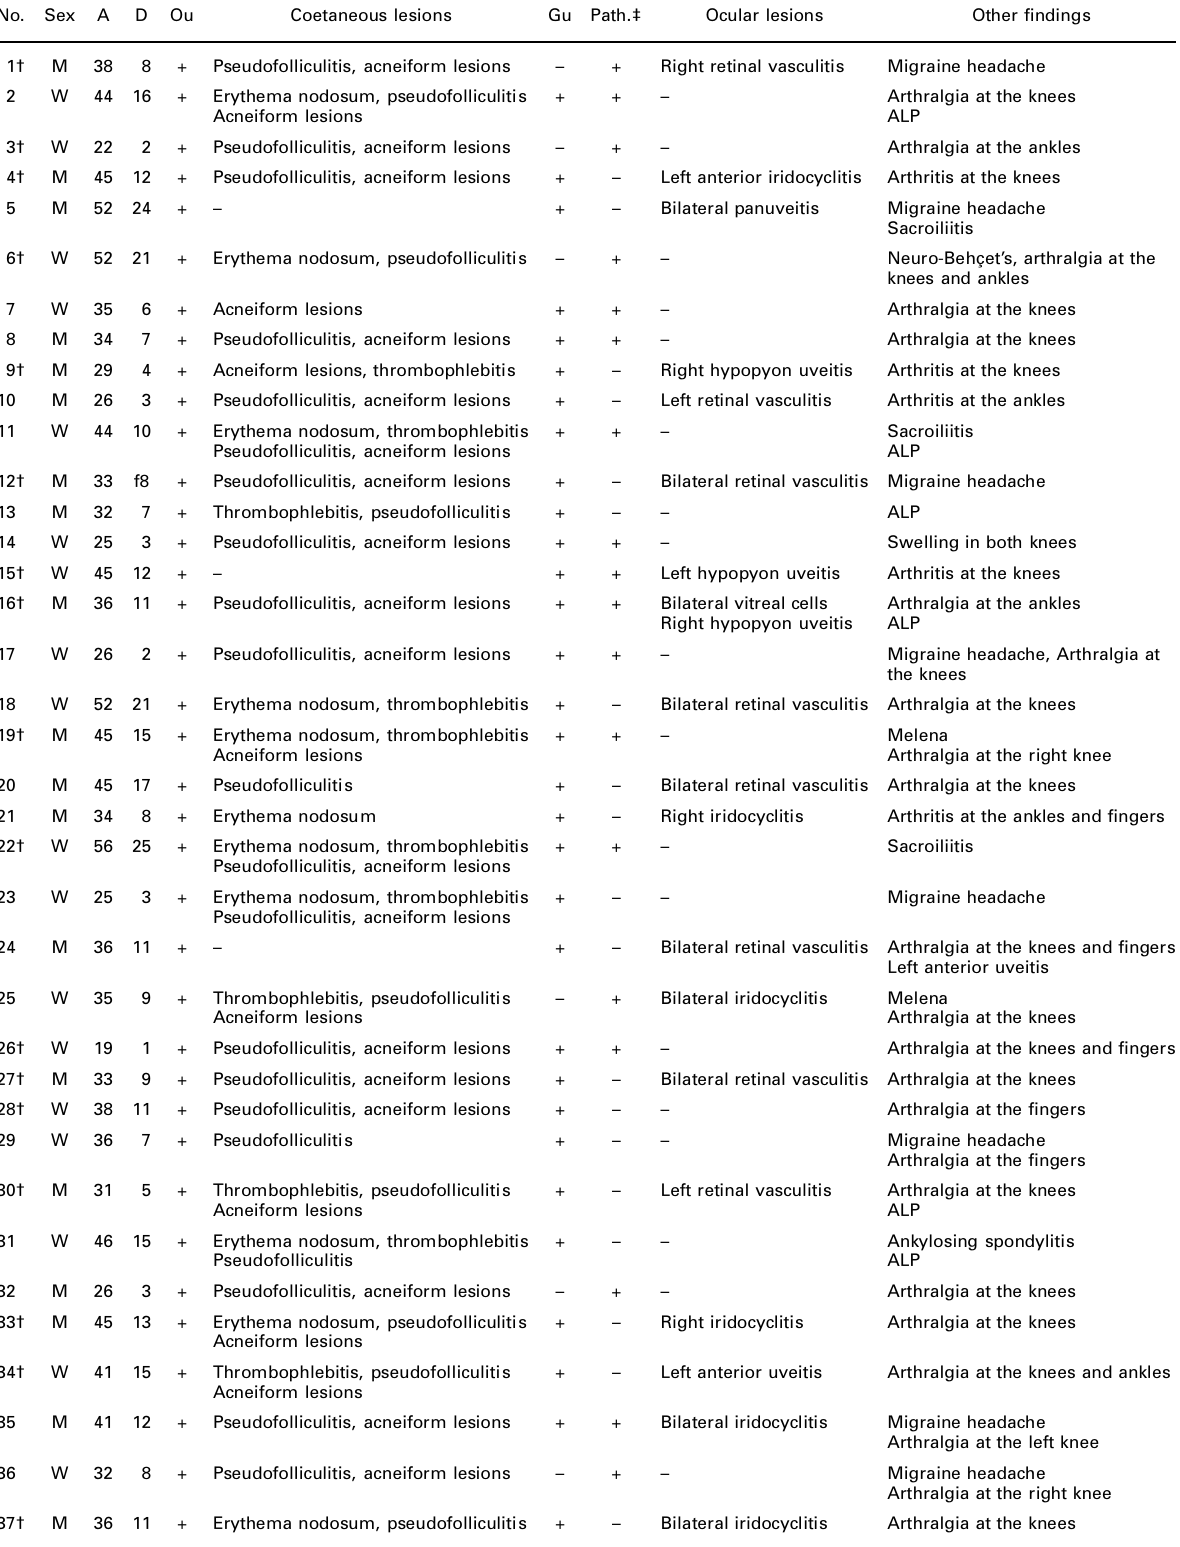
Table 1. Clinical findings of patients with active and inactive Behçet’s disease: International Study Group for Behçet’s disease criteria* for the diagnosis of Behçet’s disease No. Sex A